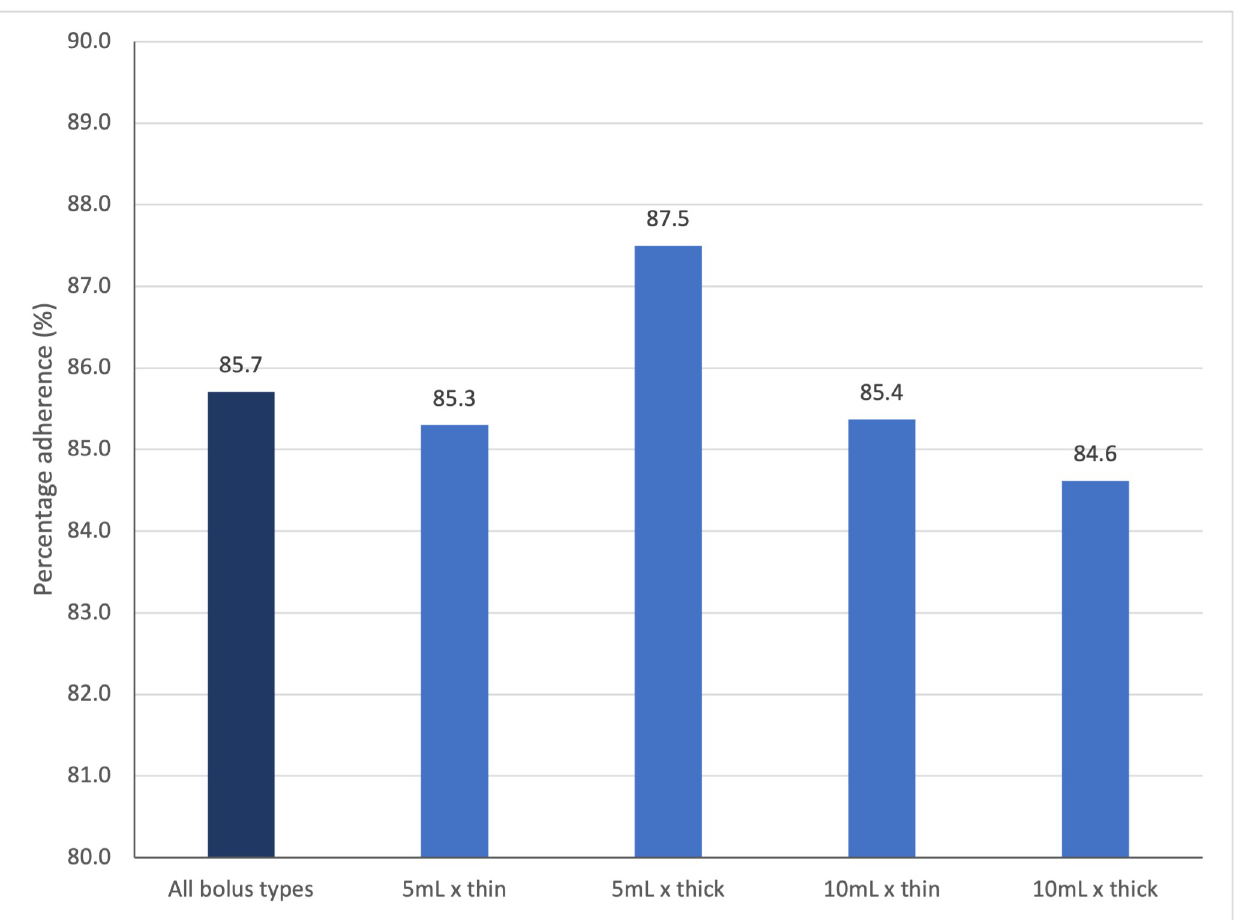
Fig 5. Percentage adherence of trials that follows the designated temporal sequence of swallowing